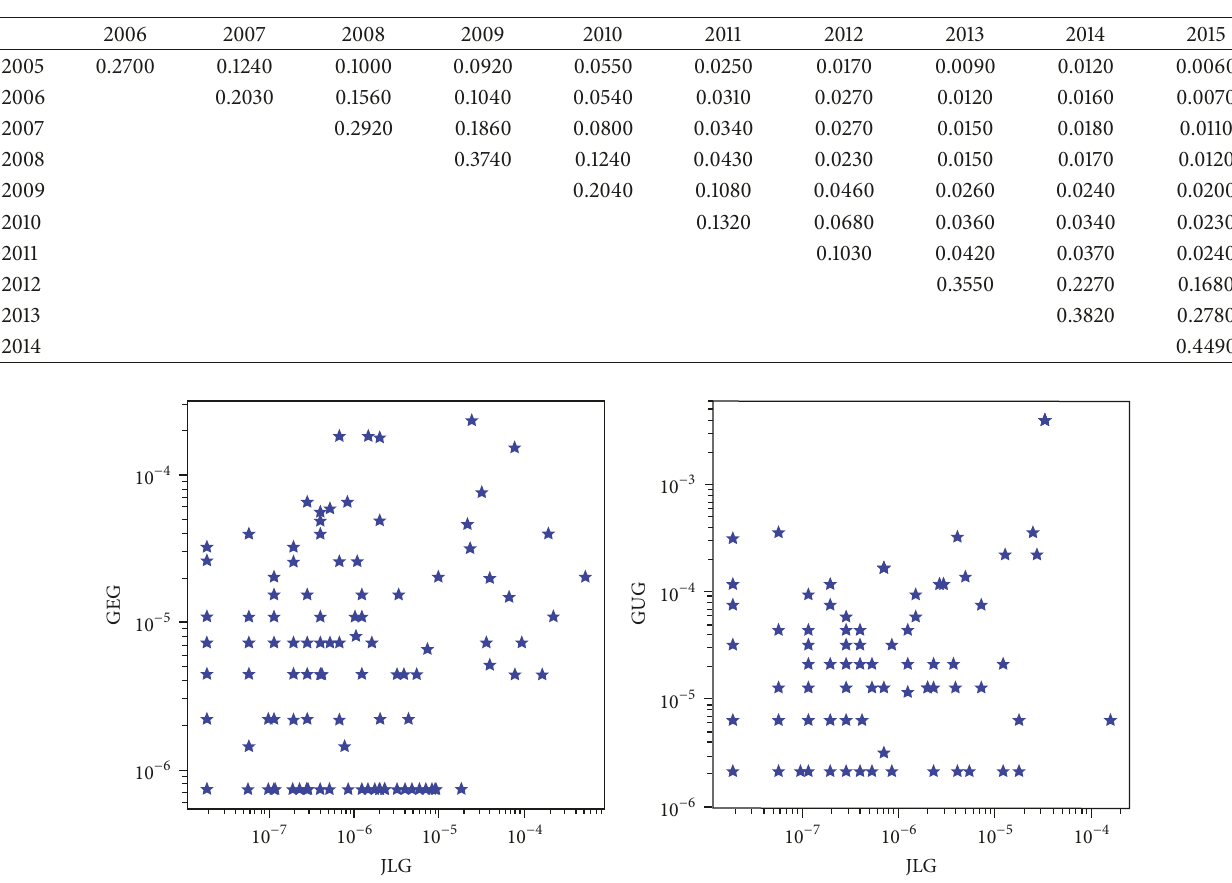
Table 4: Jaccard similarity of the GEG network over time.